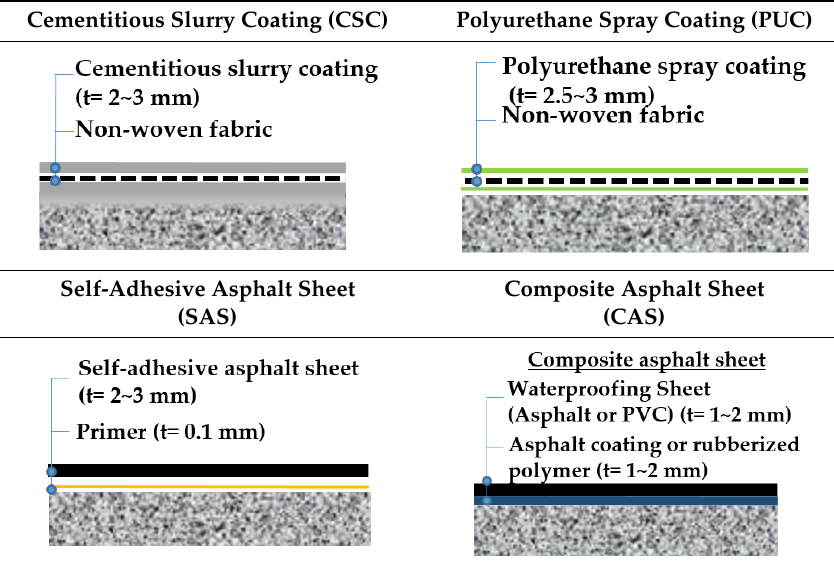
Table 6. Four waterproofing system specimens’ installation process.